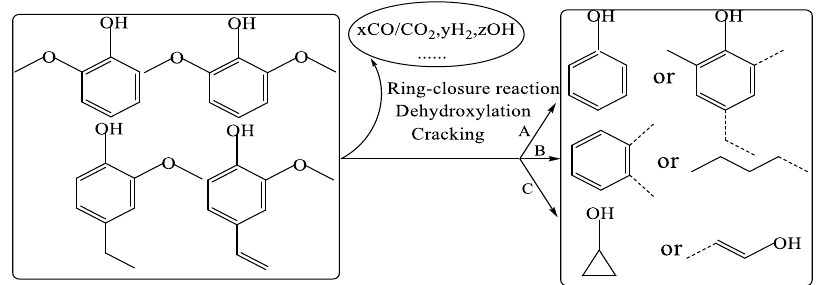
Figure 5. Possible transfer pathways of phenol.